Question: Condense the content of this figure into a single sentence.
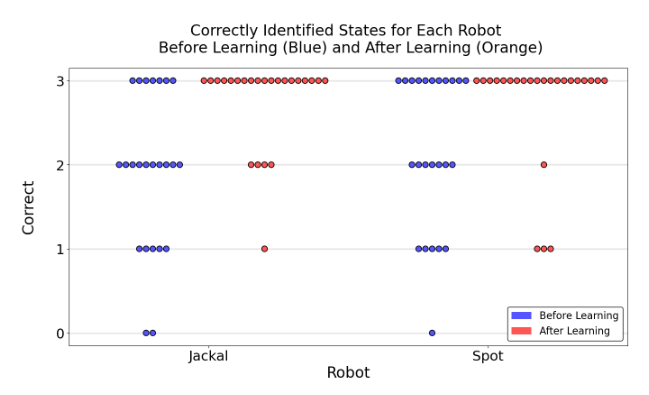
Answer: Dot plot depicting the number of states users were able to identify correctly before learning (blue) and after learning (red) with two different robots: Jackal and Spot.